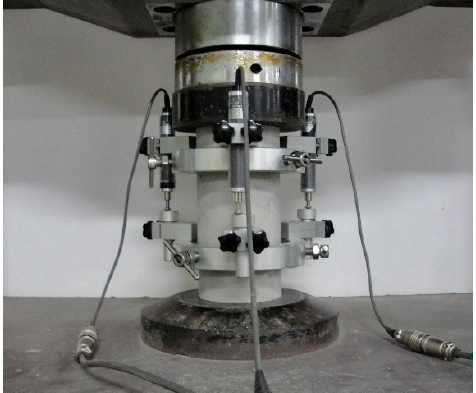
Figure 1. Experimental setup for determining static elastic modulus and compressive strength of concrete specimens.